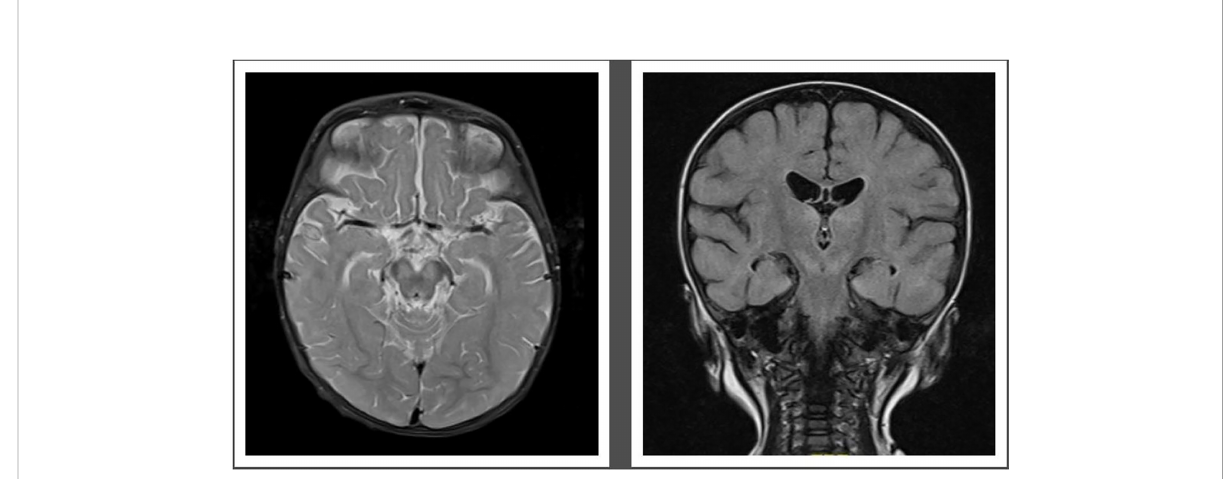
FIGURE 2 Pretreatment MRI-Brain demonstrating T2 hyperintense signal in midbrain (left) and hyperintense Fluid attenuated inversion recovery (FLAIR) signal in both thalami and midbrain